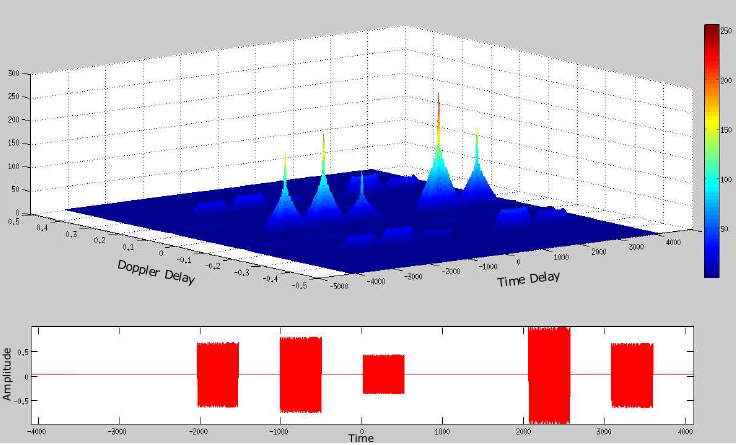
Figure 33. Multiple object tracking using MMPP “chirp pulses”, at Tracking Time 5, with no